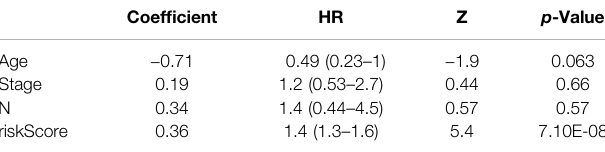
TABLE 2| Independentprognosticvalueofriskscore in multivariate